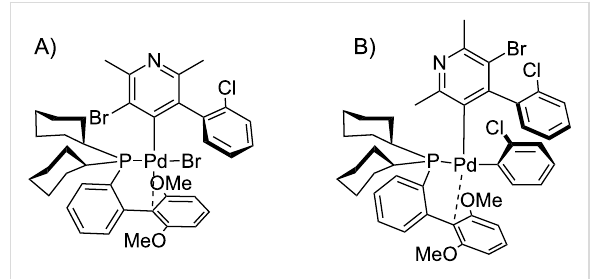
Figure 9: Proposed intermediates for the 1,2-addition with chlorine atom. A) Oxidative addition step. B) Transmetalation step.